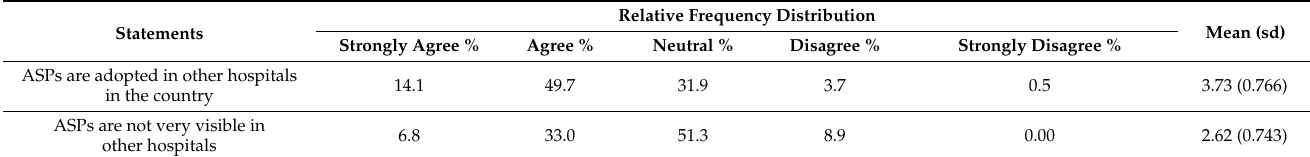
Table 5. The perceived adoption of ASPs in other hospitals.